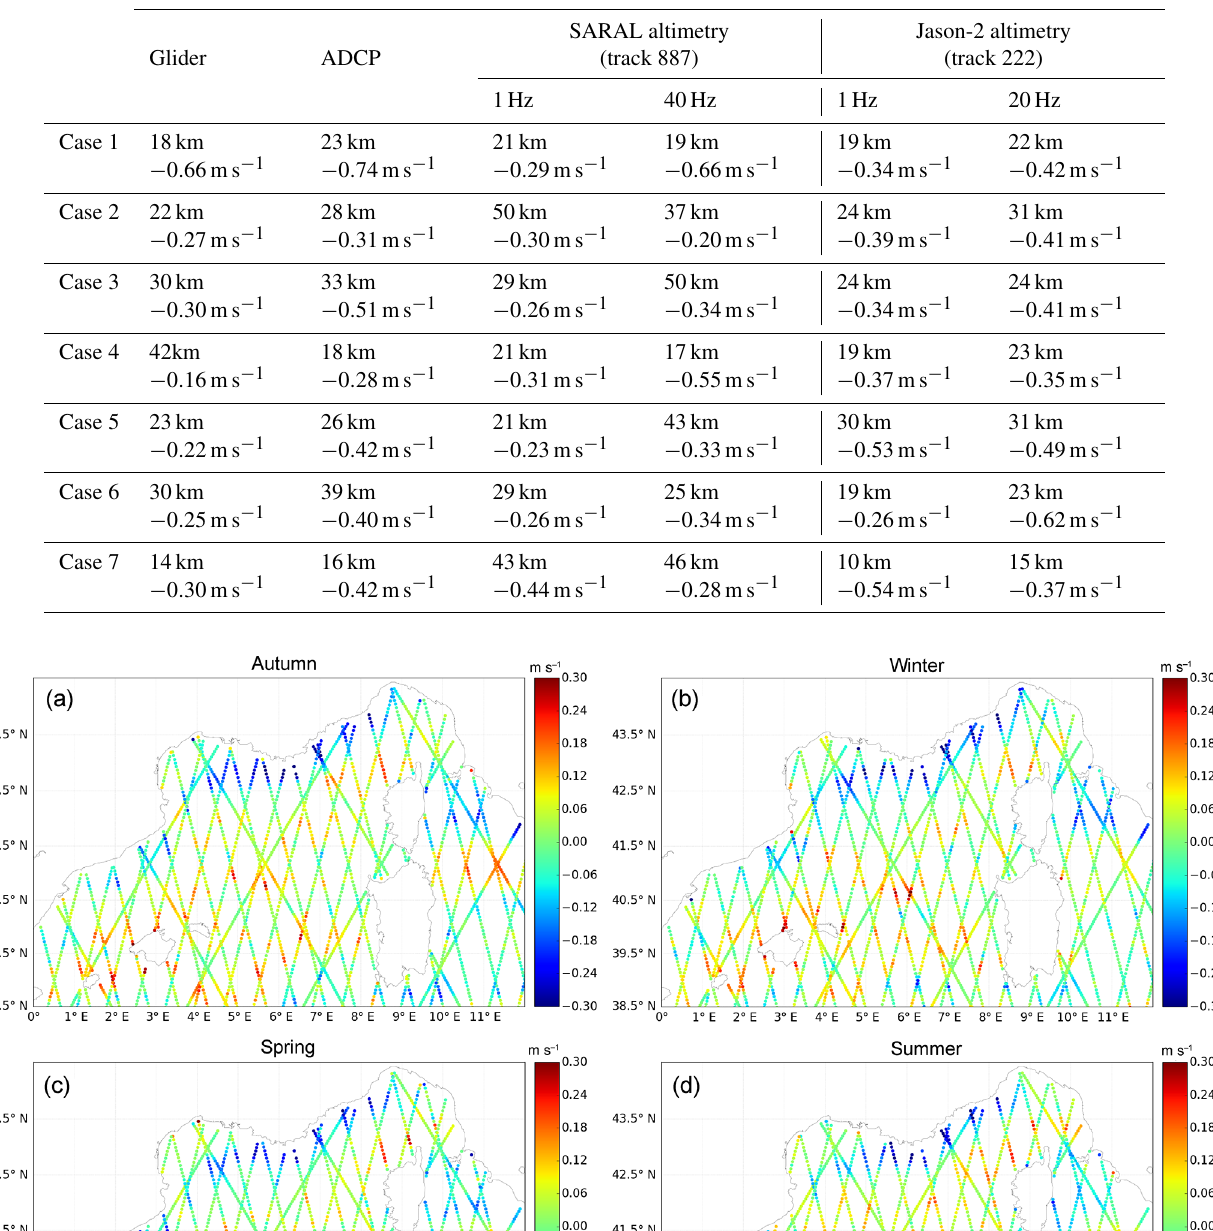
Table 4. Maximum NC value and distance to the coast of this maximum deduced from the glider, ADCP and altimetry current data for the seven individual cases listed in Table 3.